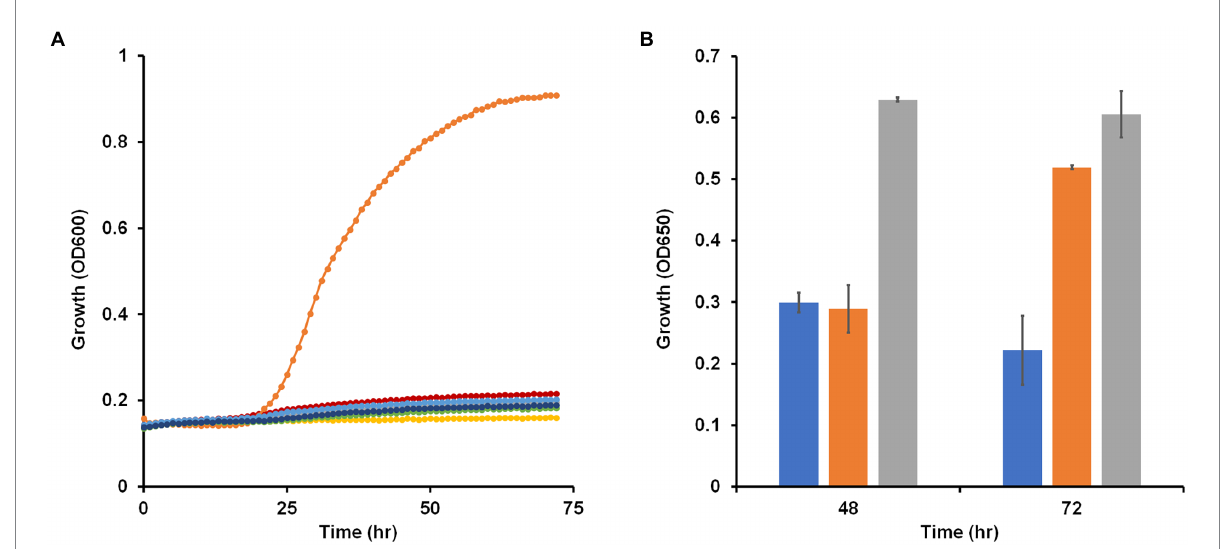
FIGURE 2 Growth of Brevibacillus massiliensis under various oxygen regimes and presence of potential electron acceptors. (A) Brevibacillus massiliensis was grown on base medium containing 5 g/l yeast extract and 5 g/l glucose aerobically (orange) or anaerobically with different electron acceptors: none (red), 20 mM nitrate (green), 2.5 mM nitrite (blue), 90 mM trimethylamine N-oxide (dark blue), 70 mM dimethyl sulfoxide (gray), or 40 mM fumarate (yellow). (B) Brevibacillus massiliensis was grown aerobically on base medium containing 2 g/l yeast extract in either sealed (blue and orange) or unsealed (gray) bottles. Growth (OD 650 ) was measured at 48 h before some of the sealed tubes were unsealed (orange) and growth (OD 650 ) was then measured again after a further 24